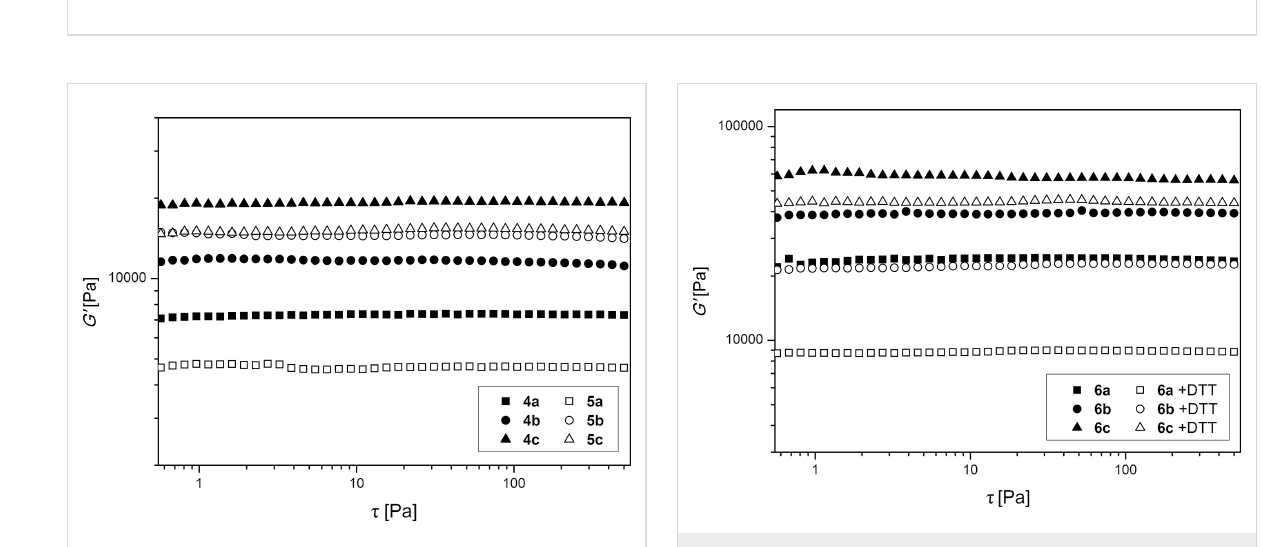
Figure 4: Storage modulus G’ of samples 6 immersed in water (full symbols) or DTT solution (empty symbols) containing 5.0 mol% CL 1 and different amounts of CL 2